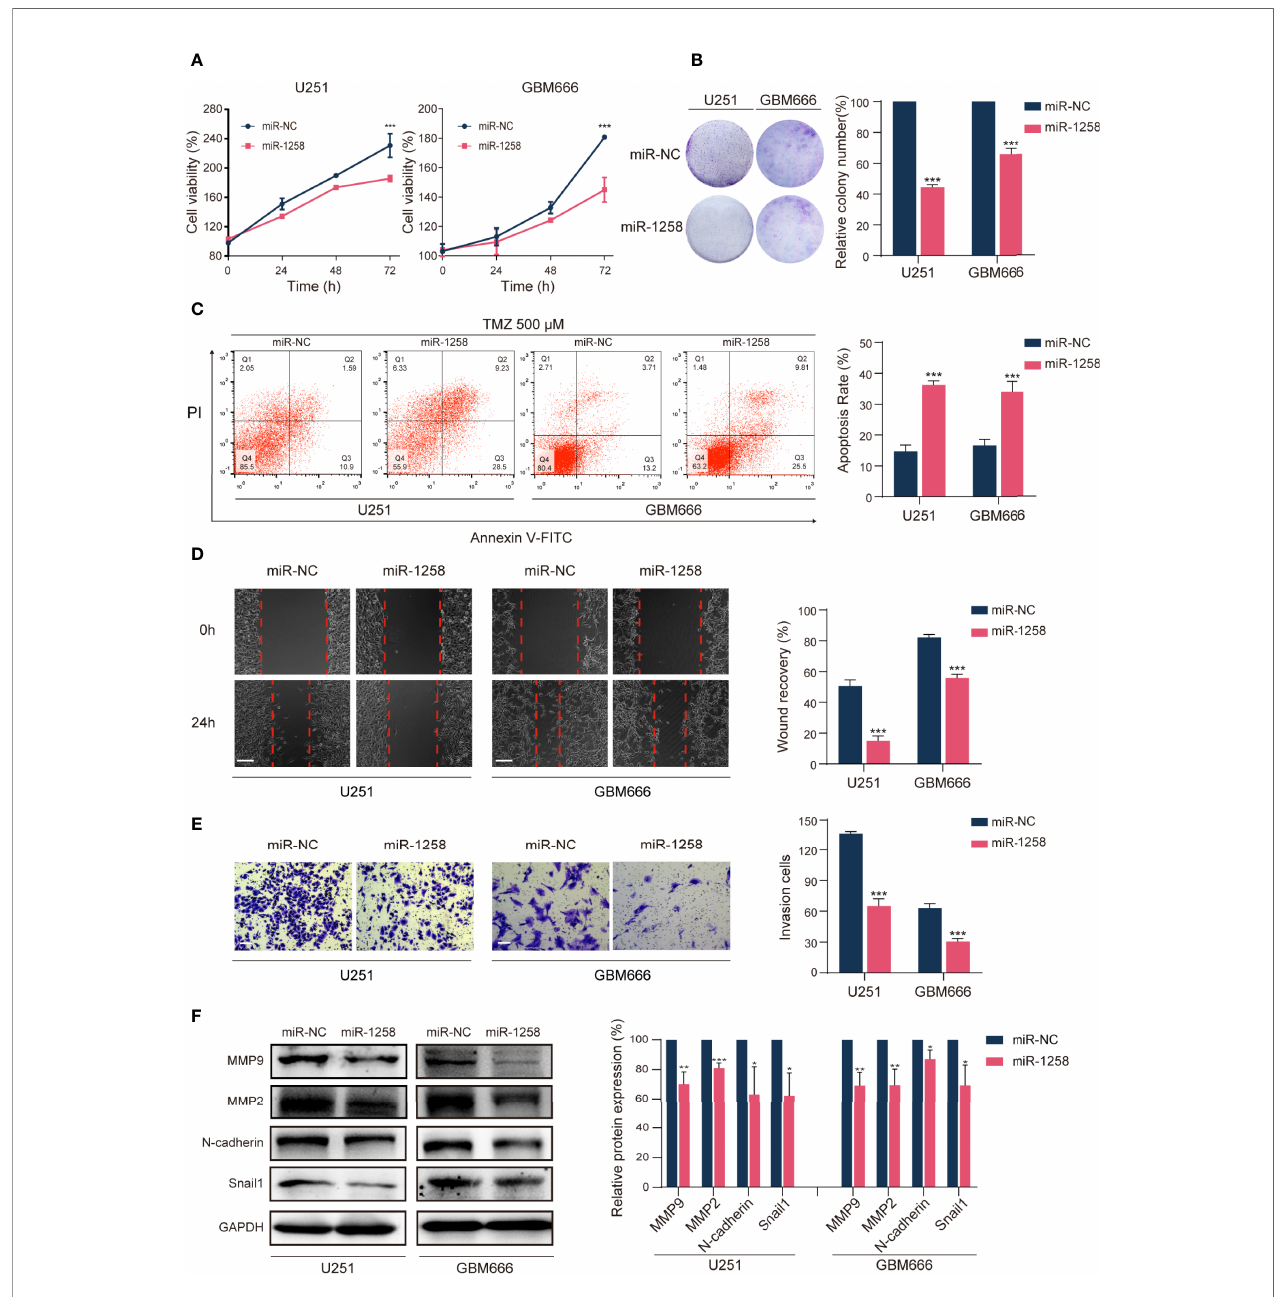
FIGURE 2 | miR-1258 overexpression attenuates GBM cell tumorigenesis in vitro . (A) CCK ‐ 8 assays detected reduced proliferation rates of U251 and GBM666 cells transfected with miR-1258 mimic after 24, 48, and 72 h; ***p < 0.001 at indicated time points, when compared to miR-NC group. (B) Colony formation detected reduced long-term cell viability of miR-1258 transfected GBM cells. ***p < 0.001 when compared to miR-NC group. (C) GBM cells were transfected with miR-1258 or miR-NC for 24 h, followed by treatment with 500 m M TMZ for 48 h, and increased apoptosis ratios were determined in miR-1258 group by fl ow cytometry; ***p < 0.001 when compared to miR-NC group. (D) Decreased migration abilities of miR-1258 transfected GBM cells were detected by wound healing scratch assays; ***p < 0.001 when compared to miR-NC group. Scale bar = 100 m m. (E) Matrigel invasion assays revealed the inhibitory role of miR-1258 overexpression on GBM cell invasion; ***p < 0.001 when compared to miR-NC group. Scale bar = 100 m m. (F) Expressions of major migration and invasion proteins were downregulated in miR-1258 transfected GBM cells detected by western blot assays; *p < 0.05, **p < 0.01, ***p < 0.001 when compared to miR-NC group. Representative images were shown and analyzed as mean ± SD from three independent